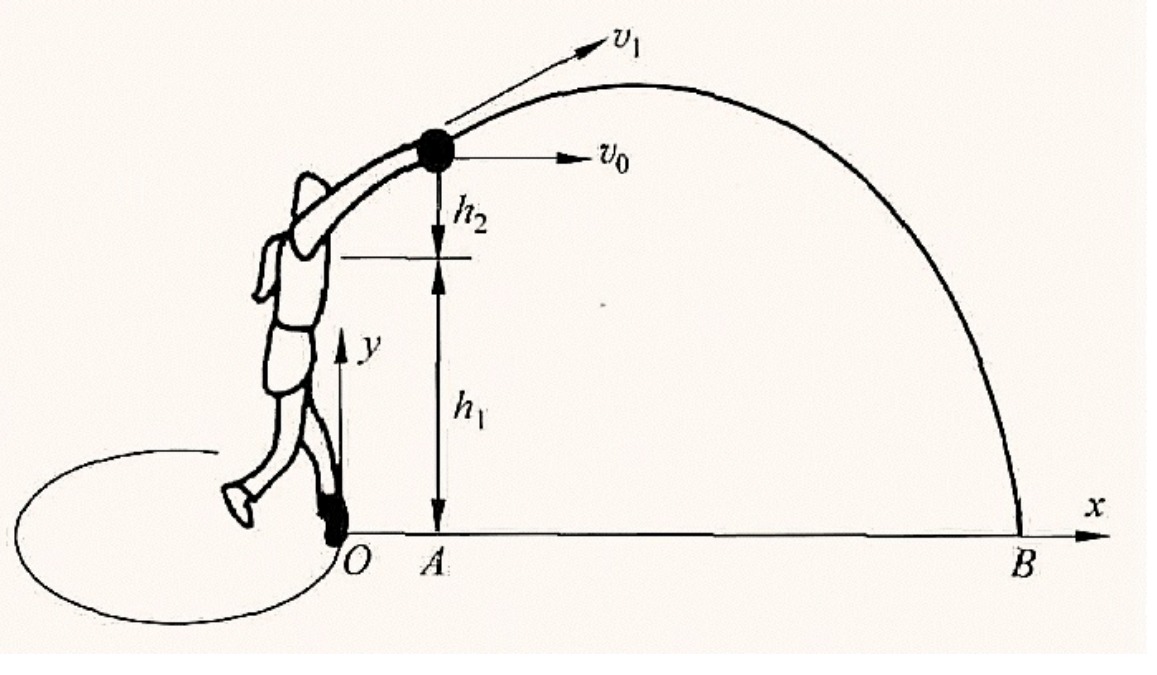
Fig. 1 Shot parameters (shot speed) and